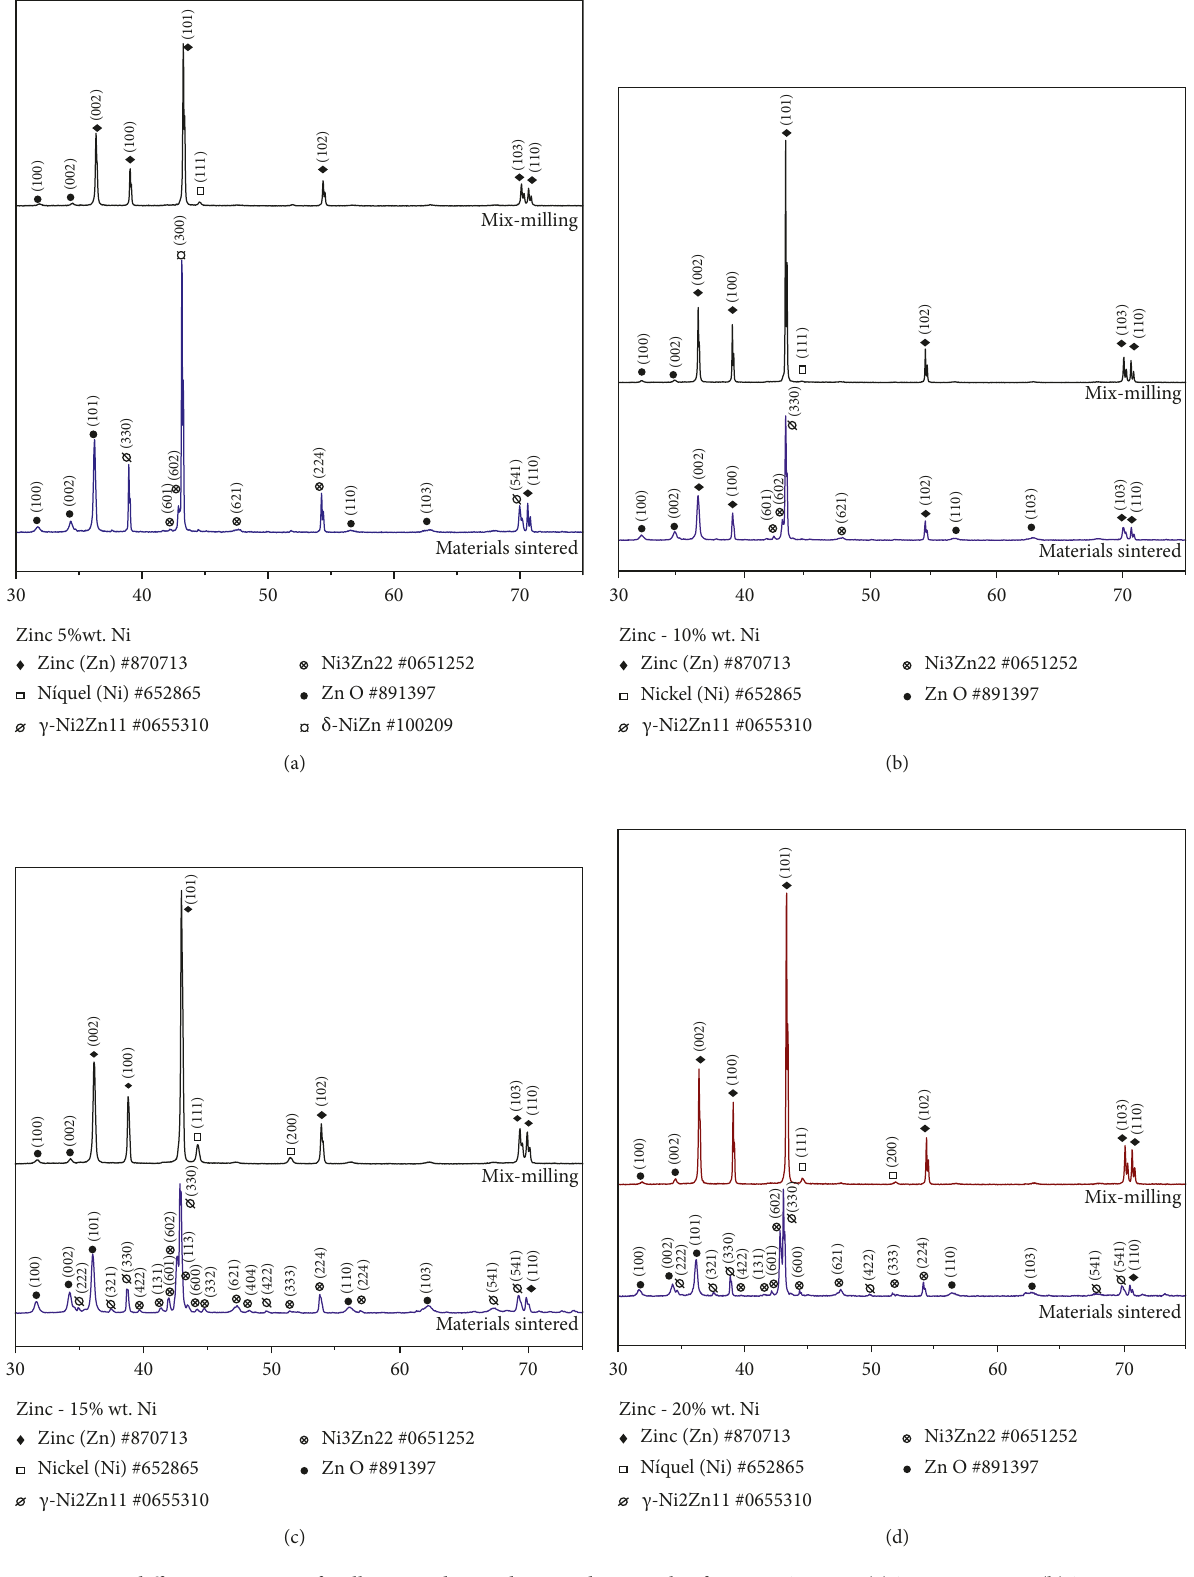
x . (a) Zinc 5%wt. Ni. (b) Zinc 10%wt. Ni.